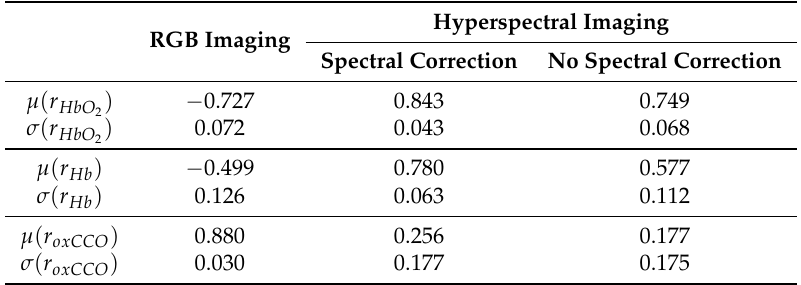
Table 5. Pearson correlation coefficients computed between the theoretical hemodynamic and metabolic responses and the simulated concentration changes’ time courses; see Figures 12 and 13. µ ( r n ) and σ ( r n ) designate the mean and standard deviation, respectively, of the Pearson correlation coefficients computed with the 10 3 noisy time courses of the chromophore n